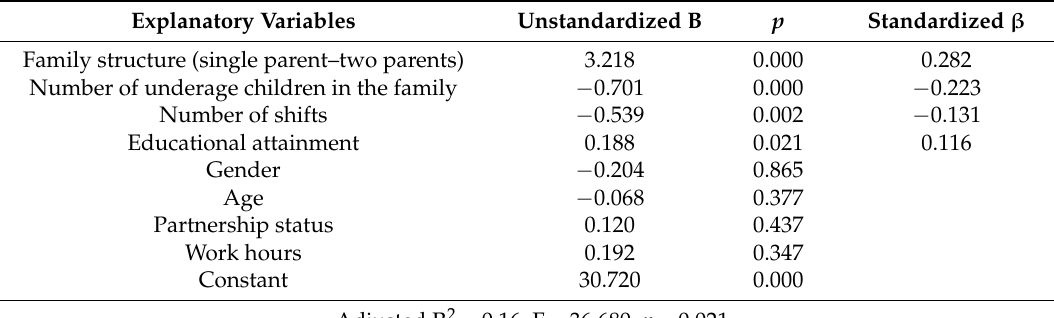
Adjusted R 2 = 0.16, F = 36.680, p =